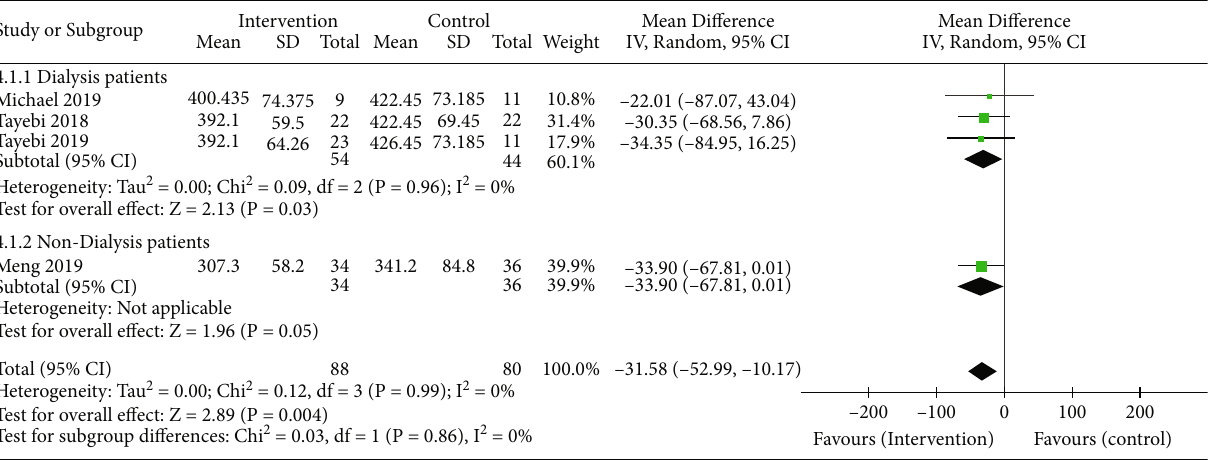
Figure 5: Pooled estimated e ff ect of RS intake on blood uric acid (mmol/L) in patients with CKD, with estimated MD and 95%